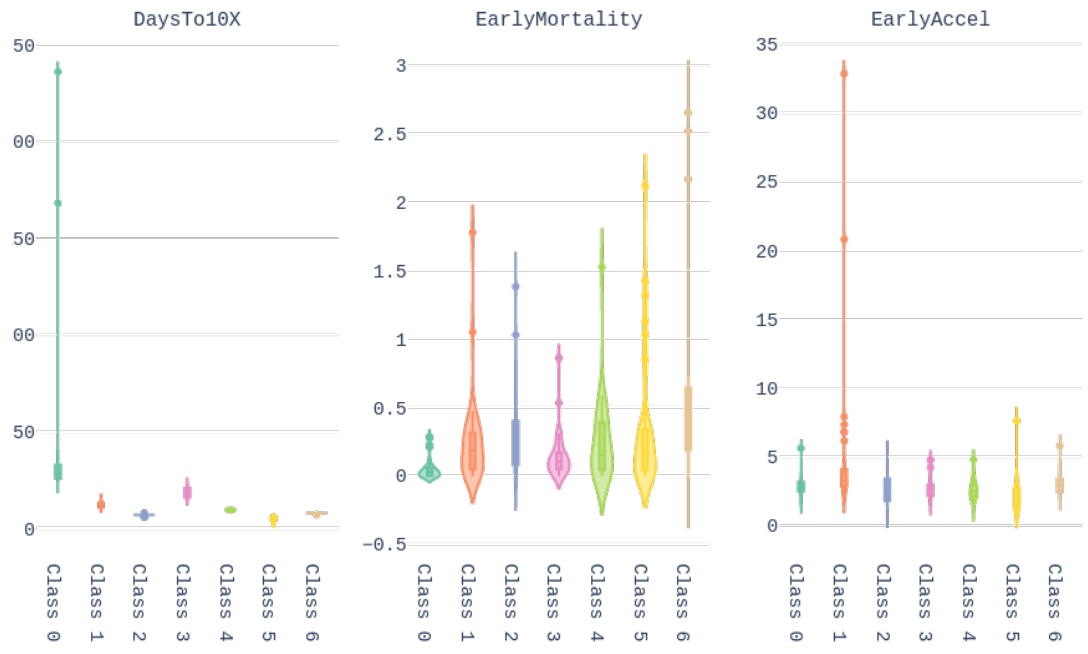
Figure 13. Violin plots representing the values taken by the different features for each groups obtained after UMAP + Affinity Propagation